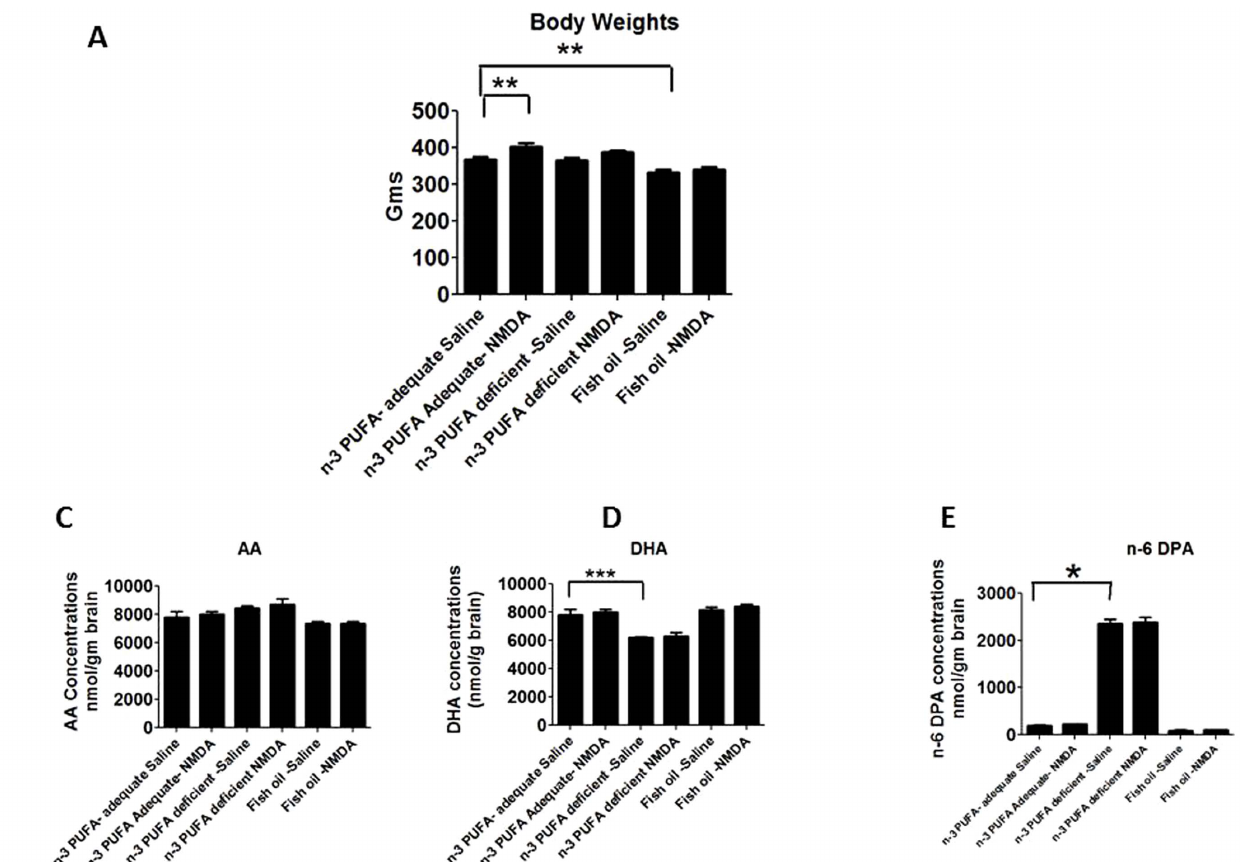
Figure 1. Brain lipid composition and activity of AA cascade enzymes. Brain lipid composition in nmol/g brain of A) Body weights B) AA C) DHA D) n-6 DPA. Data are expressed as mean 6 SEM (n=6 per group). Statistical significance is denoted by * p # 0.05, ** p , 0.01, *** p , 0.001.